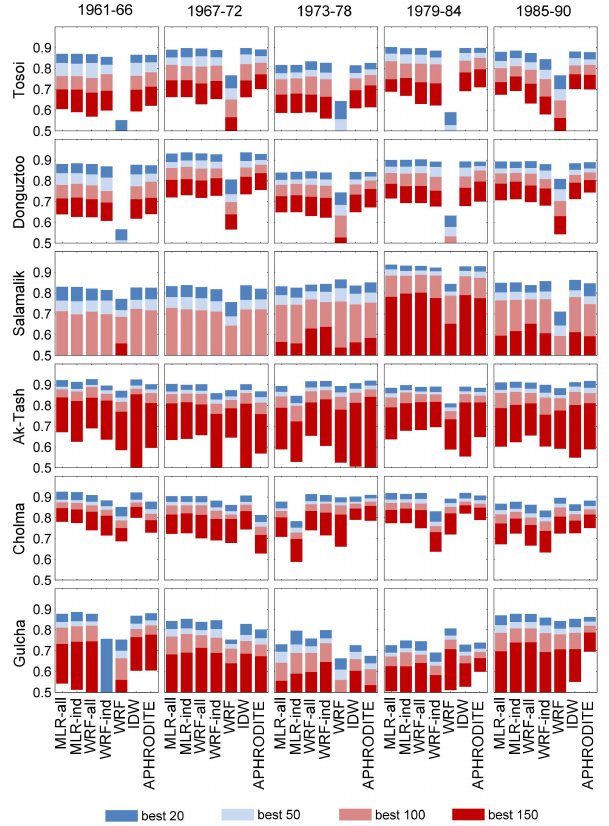
Fig. 9. Variation of the objective function values for different precipitation data sets (bars in each plot), different time periods (columns), and different subcatchments (rows). The colours indi- cate the range of objective function values for the best 20, 50, 100 and 150 parameter sets.